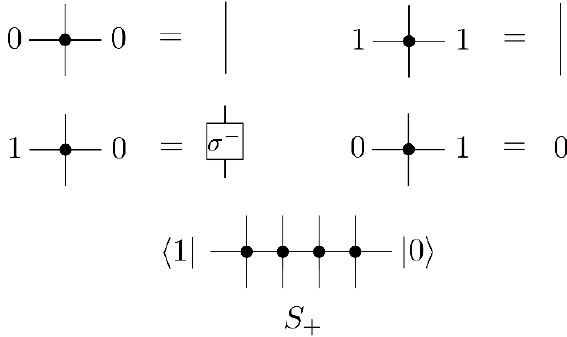
Figure 16 . An MPO description of the adjoint MPO S + .